Question: What form of chart is displayed?
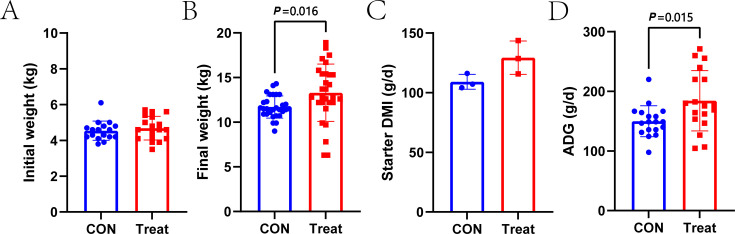
Answer: bar